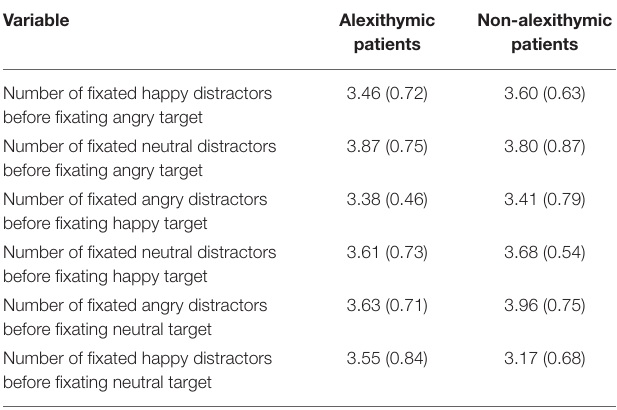
TABLE 3 | Fixation of distractor faces (number of faces) before target fixation as a function of alexithymia and emotional quality of target and distractor face [means and SD (in brackets)].